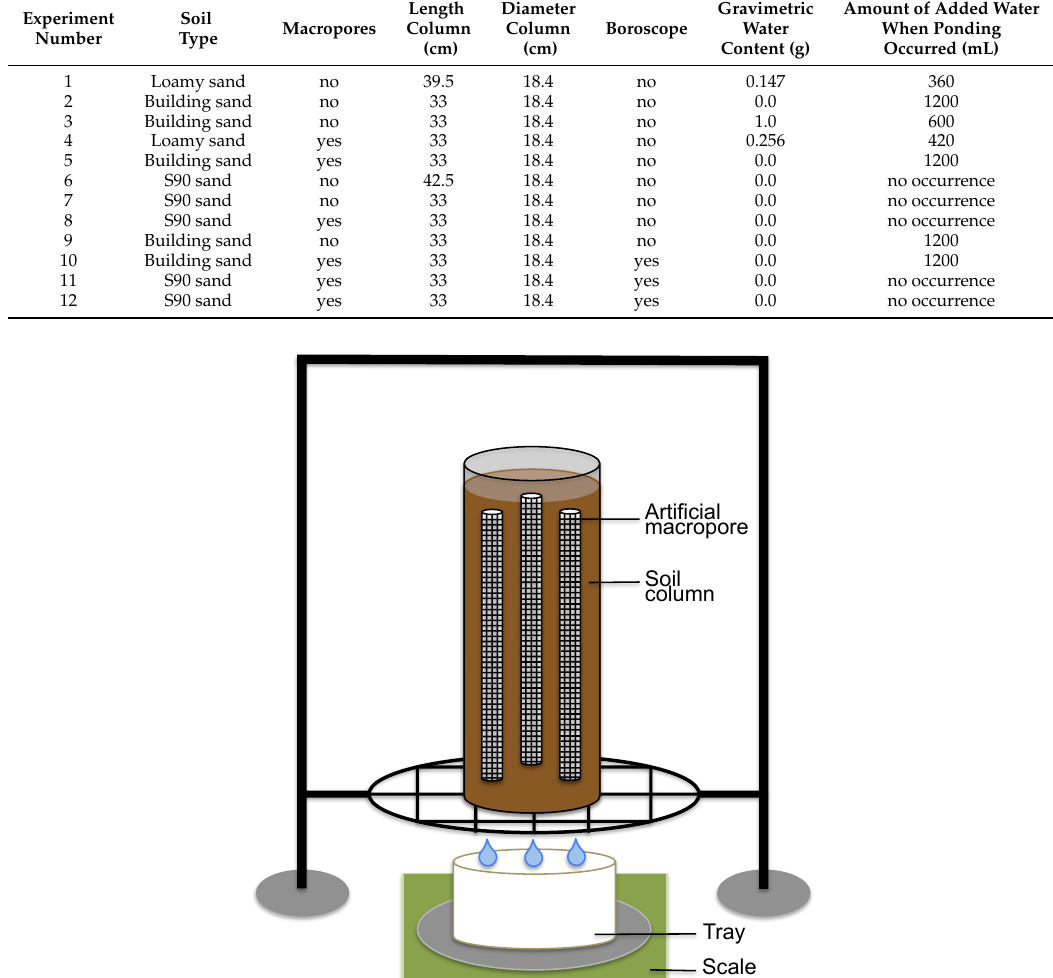
Table 1. Overview of the soil column experiments in the soil physics laboratory.